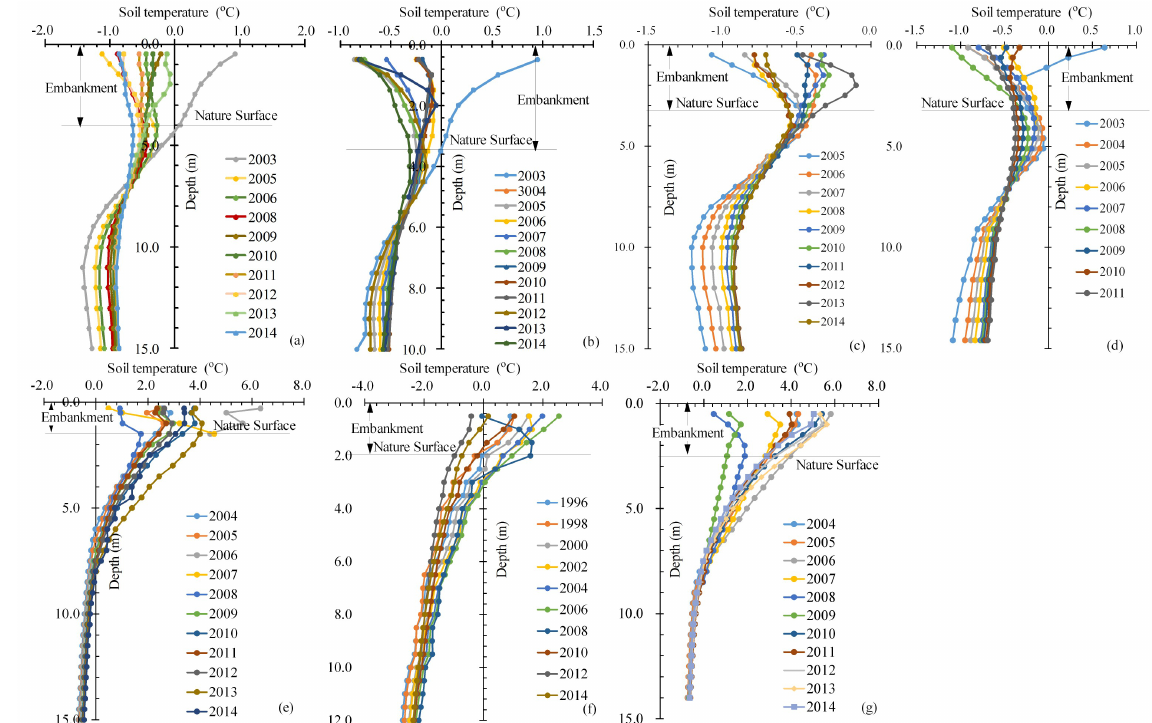
Figure 8. Change of mean annual soil temperature with depth beneath the embankments at BLR1 (a) , BLR2 (b) , BLR3 (c) , and BLR4 (d) for QTR, and at TGH1 (e) , FHH1 (f) , and KXH1 (g) for QTH in alpine